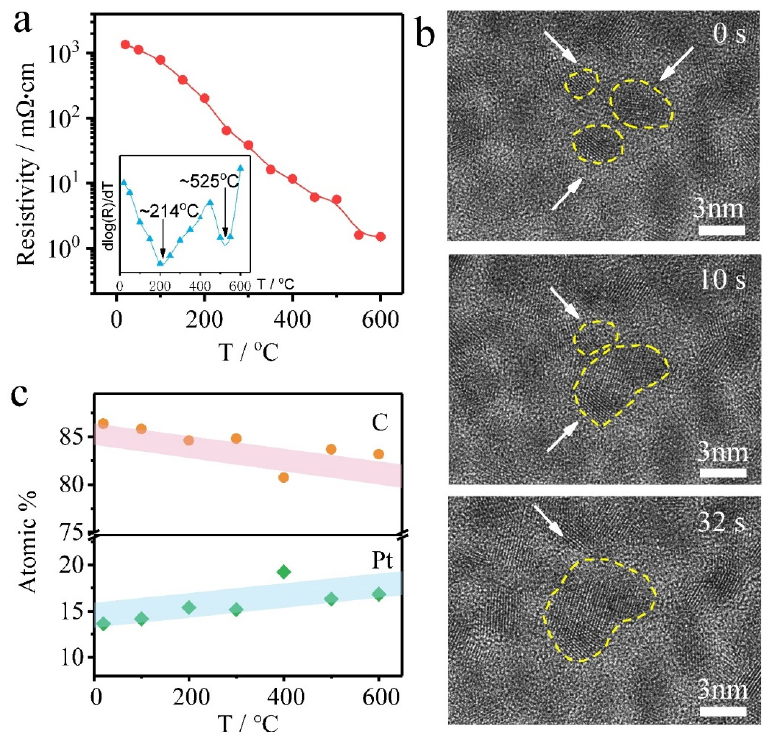
Figure 4. ( a ) Resistivity versus temperature curve of the Pt interconnector acquired from in situ biasing test in TEM and the inset is the transition temperature plots corresponding to the R-T curve calculated by dlog(R)/dT. ( b ) HREM images show the real-time grain growth and combination process during the in situ heating procedure at 250 °C. ( c ) The atomic percentage variation of C and Pt elements with temperature.